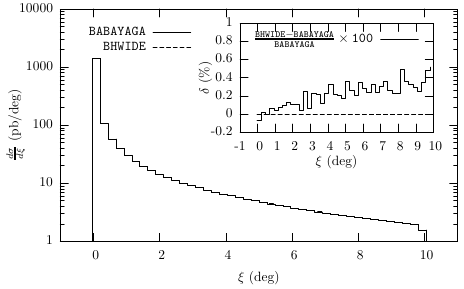
Figure 1. Comparison between BabaYaga@NLO and Bhwide on the acollinearity distribution.